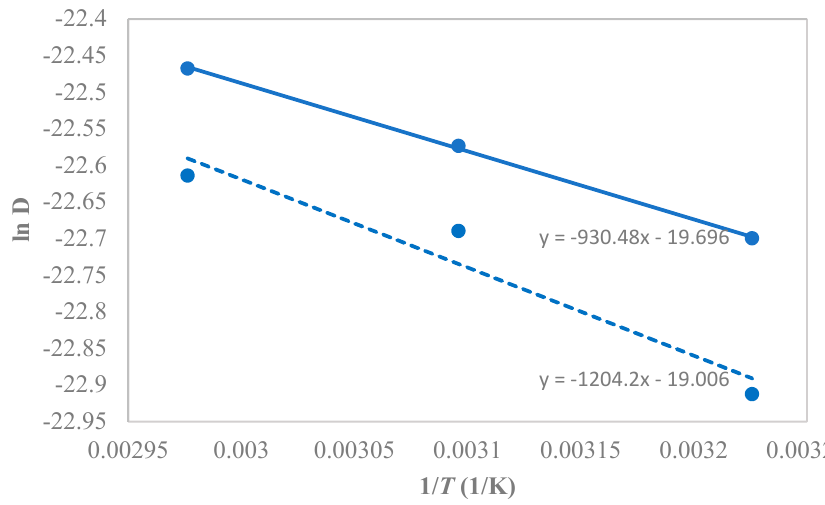
Figure 13. Arrhenius-type plot for the temperature dependence of the 1-butanol diffusivity in PTMSP-SNPs and neat PTMSP membranes at 1.5 w/w% feed 1-butanol concentration. The solid line represents the hybrid PTMSP-SNPs membrane and dotted lines for the neat PTMSP membrane. Data for pure PTMSP were taken from the literature [26].